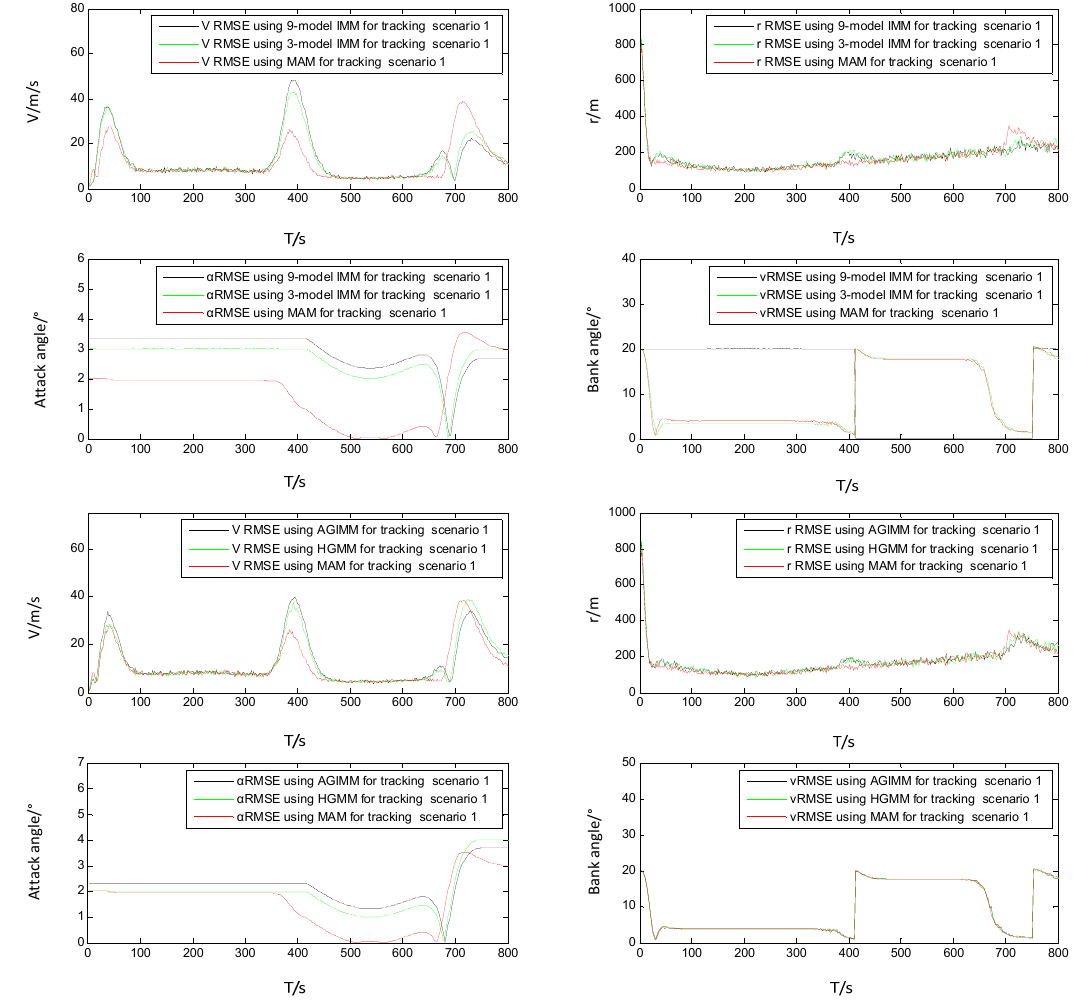
Figure 2. Root mean square error (RMSE) for tracking Scenario 1. Table 2. The performances for stably tracking Scenario 2.